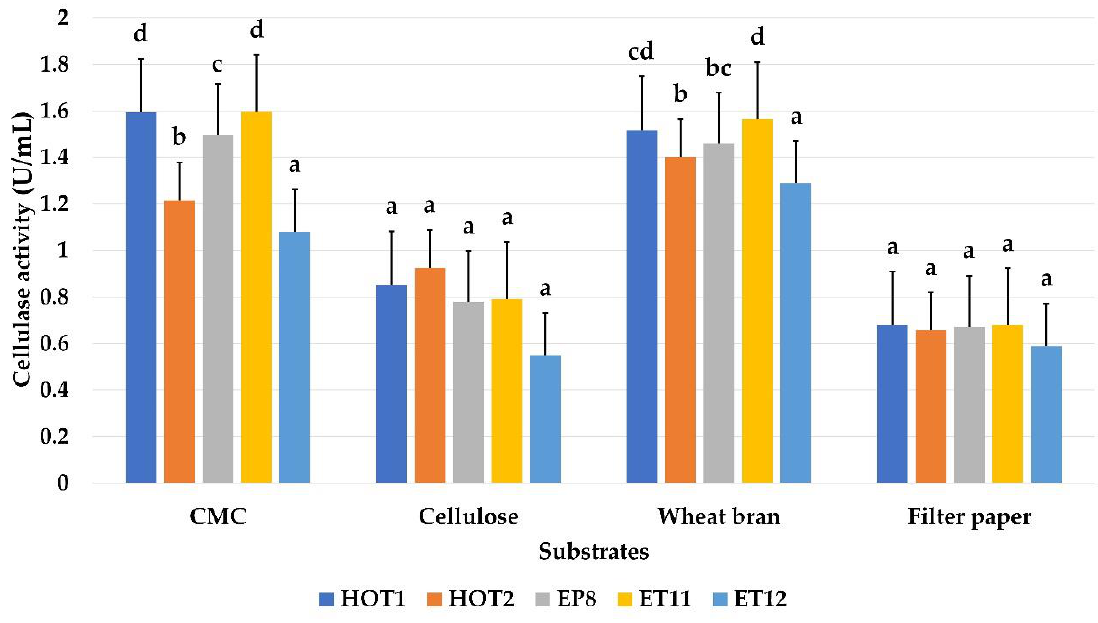
Figure 9. Cellulase activity on different substrates of the strains tested. The results are expressed as the mean-standard error of the values of the enzymatic unit in duplicate. The cellulase activities on different substrates corresponding to each treatment and not sharing the same letters are significantly different according to Tukey ’ s post hoc HSD test.